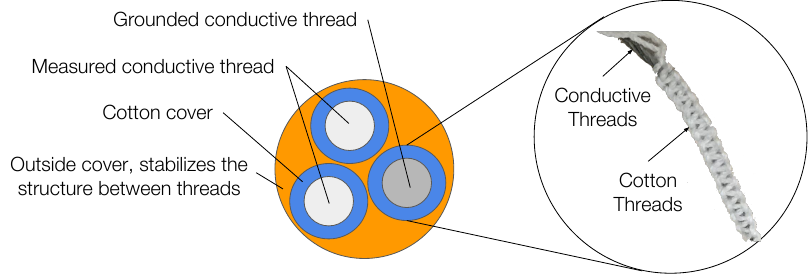
Figure 3. Cotton cover with square knots